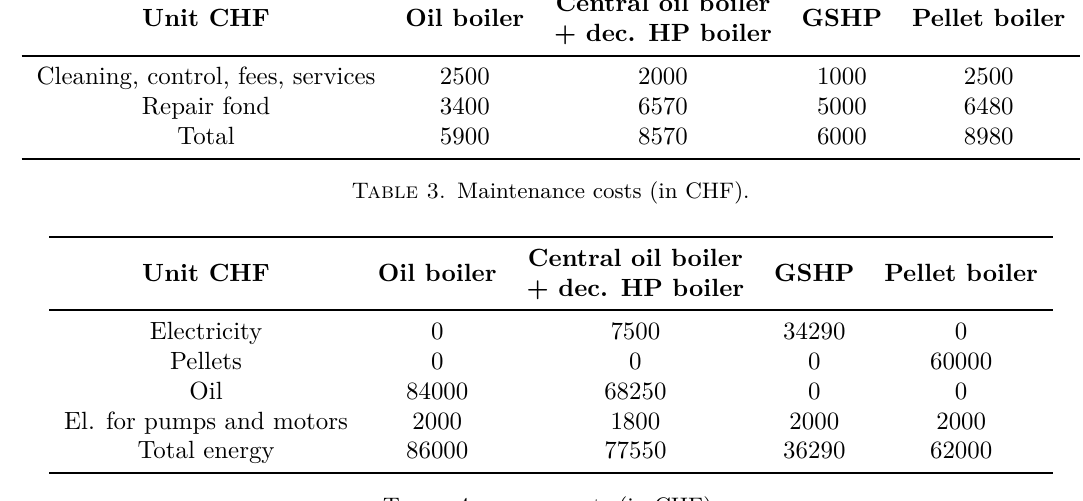
Table 4. energy costs (in CHF).